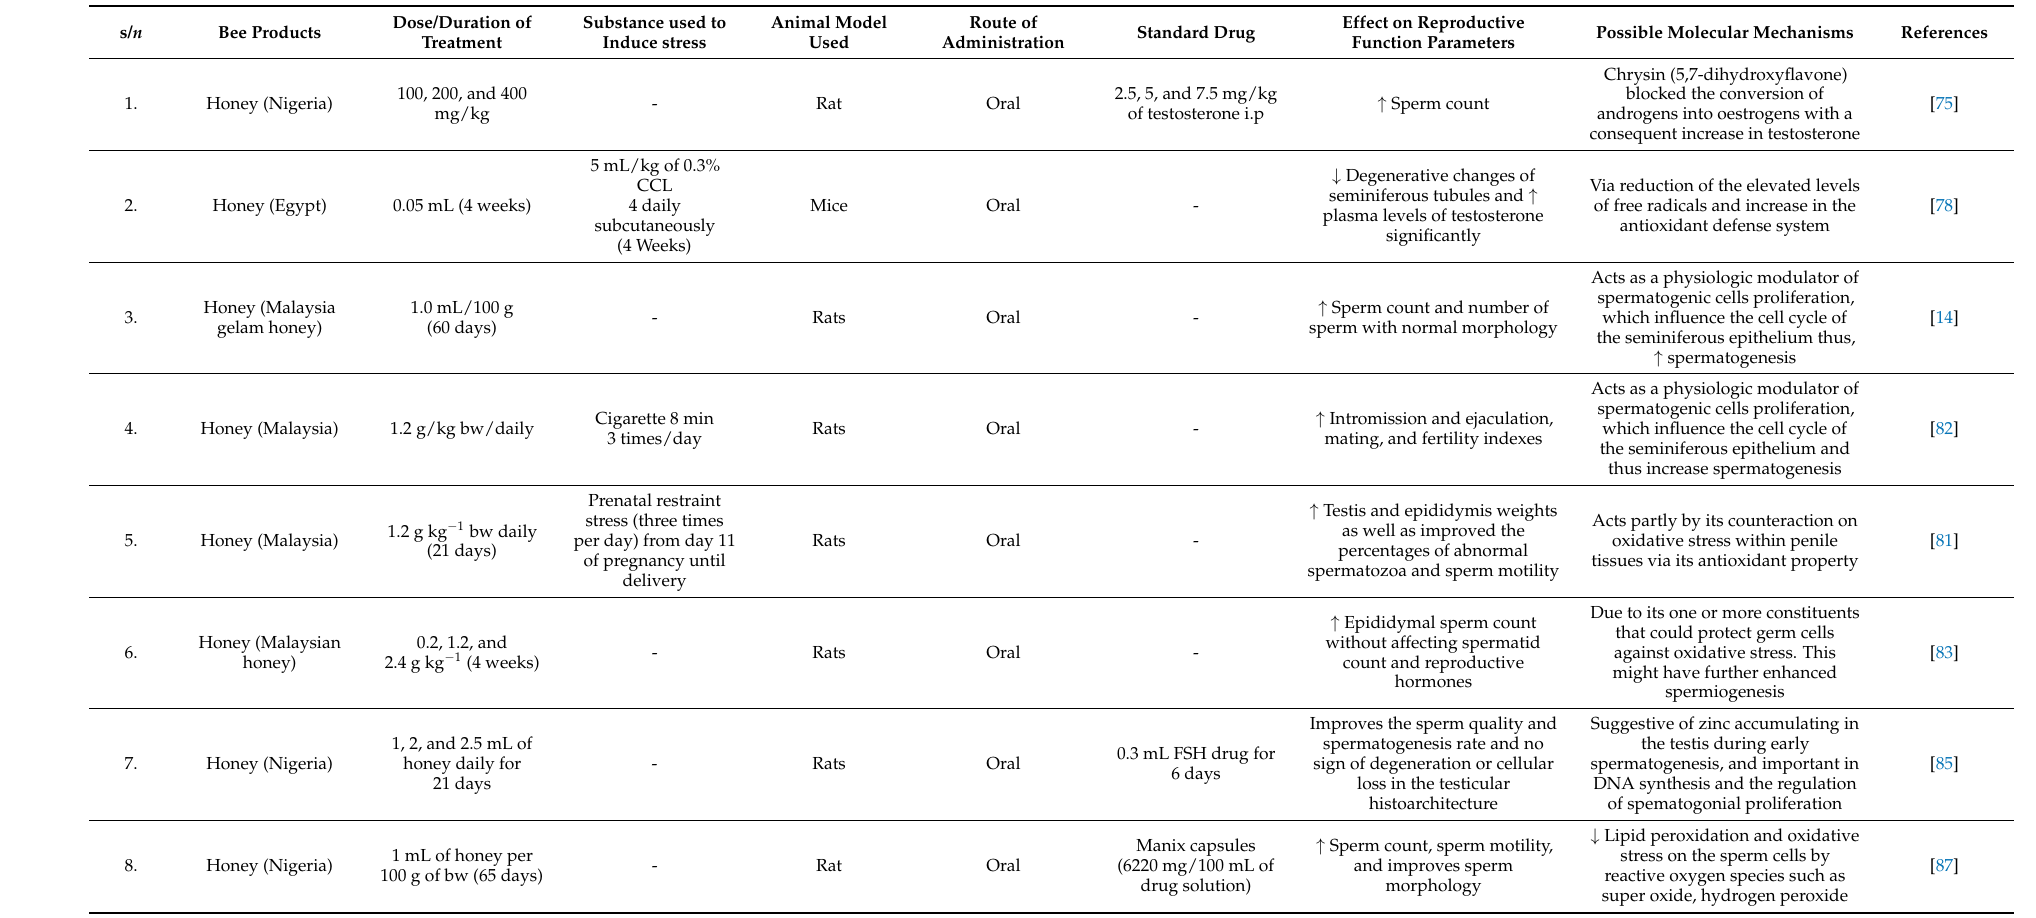
Table 3. Effects of honey on male reproductive